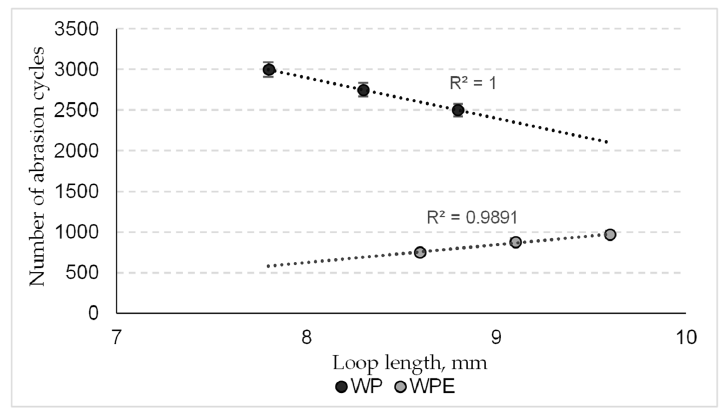
Figure 6. Abrasion